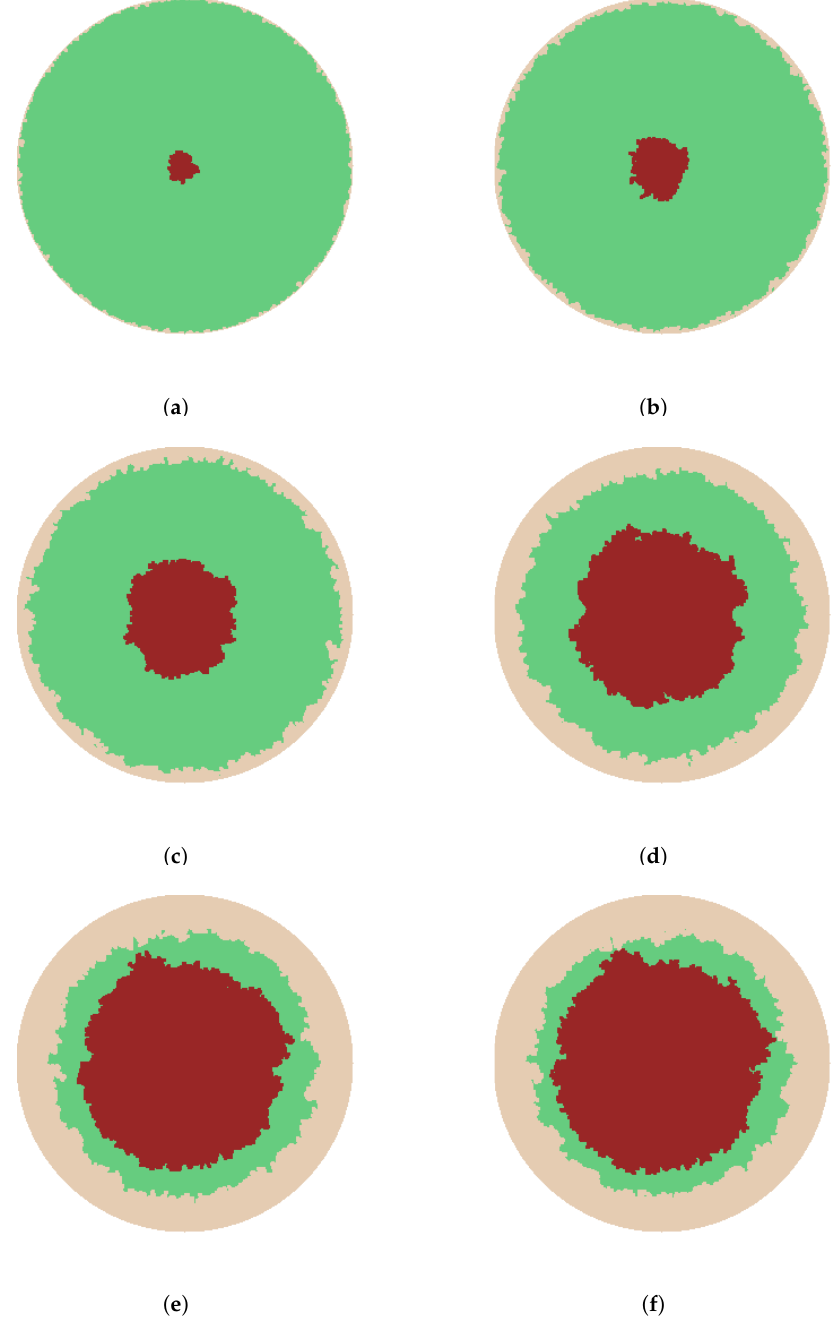
Figure 4. Eden model simulation of epithelialization and bacteria infection for a circular skin wound. is wound space, is epithelialization, and is bacteria growth. The progression of epithelialization showing wound contraction, and bacteria growth showing the scale of infection are given. Compared to the initial wound, re-epithelialization and bacteria burden at the different stages are approximately ( a ) 3% and 1% ; ( b ) 6% and 3%; ( c ) 15% and 12%; ( d ) 29% and 27%; ( e ) 39% and 38%; and ( f ) 42% and 40%. The stage ( f ) represents a stall chronic wound. The epithelialization and bacteria growth rates are